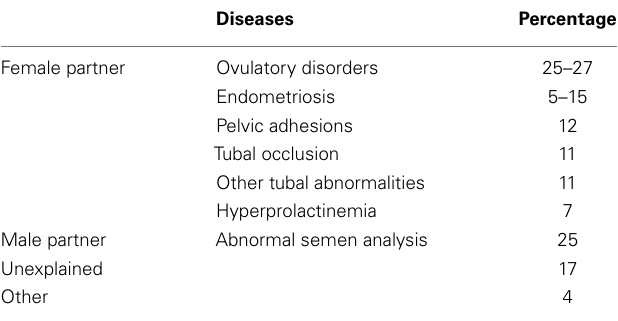
Table 1 | Frequency of diseases associated with infertility (1)